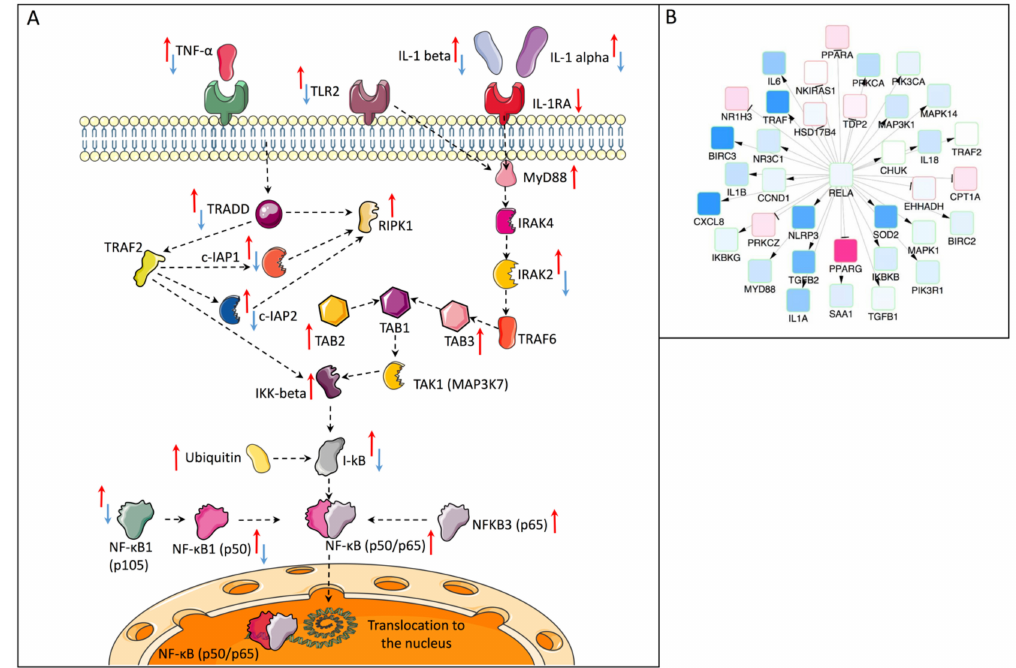
Figure 3. Gene ontology (GO) biological process and KEGG pathway enrichment analysis. ( A ) GO and ( B ) KEGG pathway enrichment analysis of biological processes on the 28 differentially expressed genes in oral epithelial cells when TNF- α + RvD1 n-3 DPA and TNF- α addition were compared.